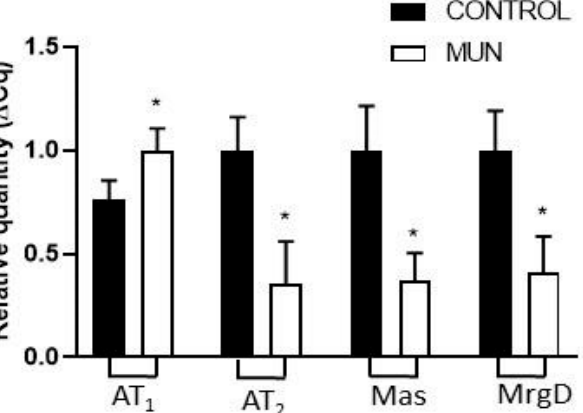
Figure 2. Influence of fetal undernutrition on the expression of RAS receptors in 6-month-old male offspring from rats exposed to maternal undernutrition during pregnancy (MUN) and rats fed ad libitum (CONTROL). Expression of AT 1 , AT 2 , Mas and MrgD receptors in mesenteric arteries from MUN and CONTROL rats. RT-PCR analysis of transcripts for AT 1 , AT 2 , Mas and MrgD receptors. Results are normalized to the 28s gene and fold changes between MUN and CONTROL. Values are expressed as mean ± s.e.m. from 6 rats in each group. Significant differences from CONTROL rats: * p < 0.05.